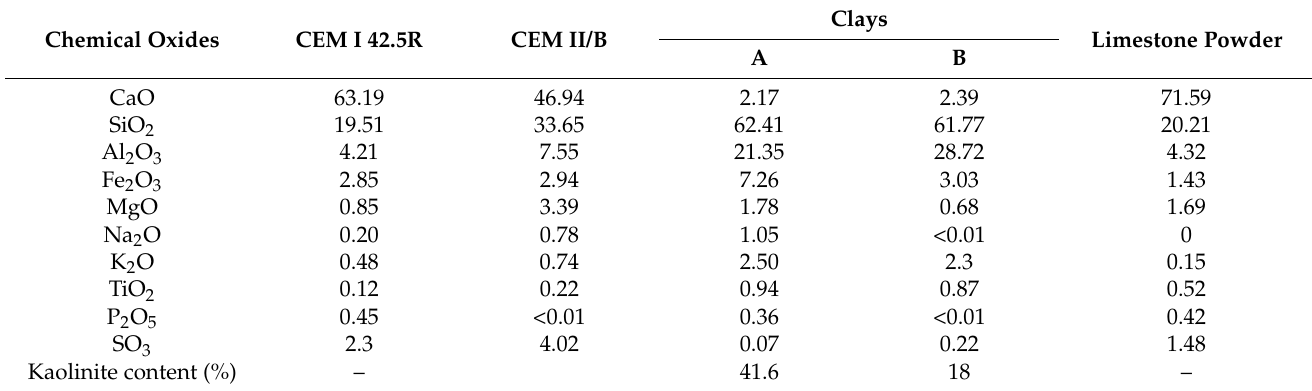
Table 1. Chemical oxides of each material used in this study.